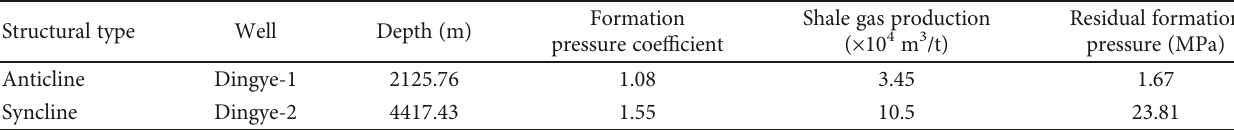
Figure 6: The cross-section of the structural characteristics of the Dingshan block and the structural location of Dingye-1 and Dingye-2 Wells. Modi fi ed from Wei et al. (2017). See Figure 1 for the well locations. Table 5: The burial depth, formation pressure coe ffi cient, and residual formation pressure of the target in Dingye-1 and Dingye-2 Wells in the Dingshan block. See Figure 1 for the well